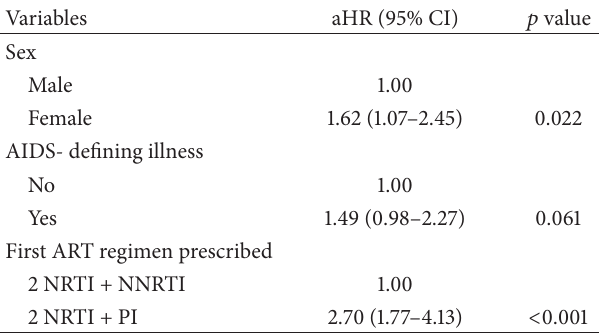
Table 3: Adjusted hazard ratio and 95% confidence interval (95% CI) estimated by Cox proportional hazards regression in multivari- ate analysis of the historical cohort for first ART modification, Belo Horizonte,